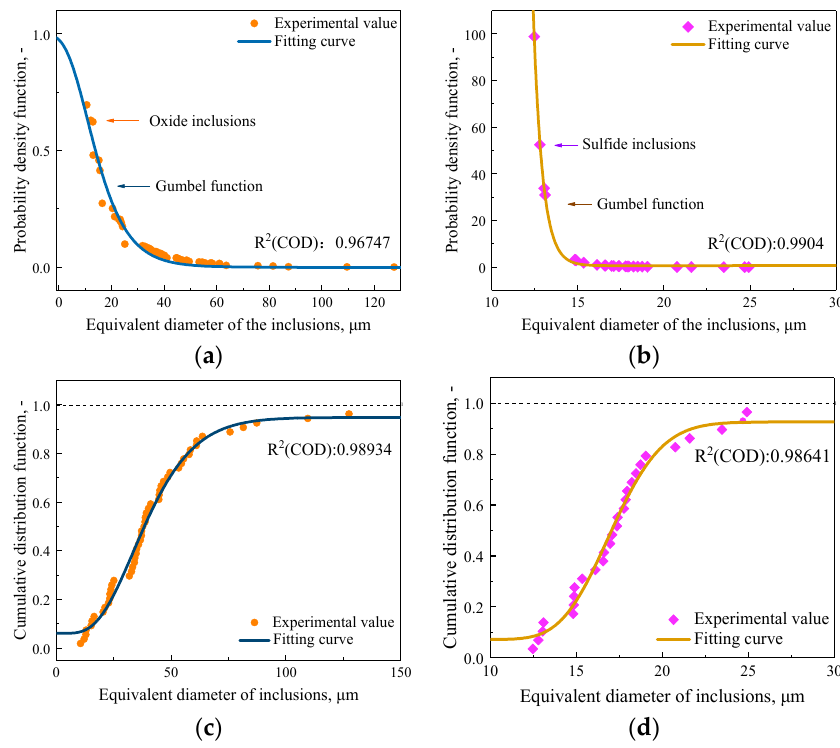
Figure 13. Probability density function and cumulative distribution function curves of the maximum of oxide inclusions ( a , c ) and sulfide inclusions ( b , d ) in different fields of view. The predicted value of the extreme value distribution is related to the total size of the sample. Generally, the larger the sample, the higher the predicted value will be. The draw-